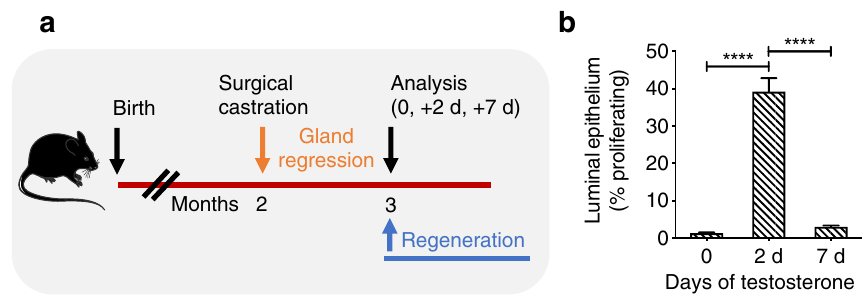
Figure 2. Assessment of epithelial cell cycling in the regenerating prostate. ( a ) Experimental design assessing time course of prostate epithelial cell proliferation after testosterone administration (via subcutaneous Alzet pumps). Blue lettering = periods when testosterone is present. Orange lettering = periods when testosterone is absent; ( b ) Quantification of testosterone-responsive luminal epithelial cell proliferation (by Ki67 positivity in CD24 + EPCAM + cells, quantified by FACS) post testosterone administration. n = 4 mice per condition. ****P < 0.0001. Error bars indicate